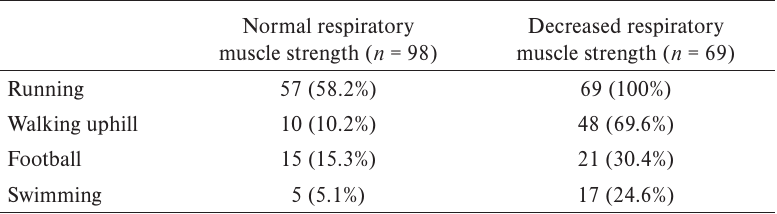
Incidence of breathing disorders in children with asthma with normal and decreased respiratory muscle